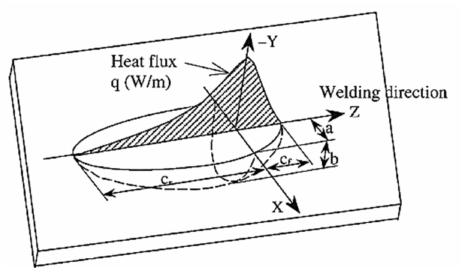
Figure 1. Goldak’s double ellipsoidal distributed heat source